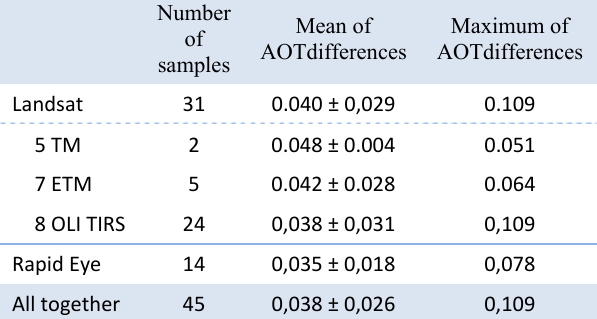
Table 3. AOT retrieval uncertainty for cloudless and cloudy images of the regional and global data